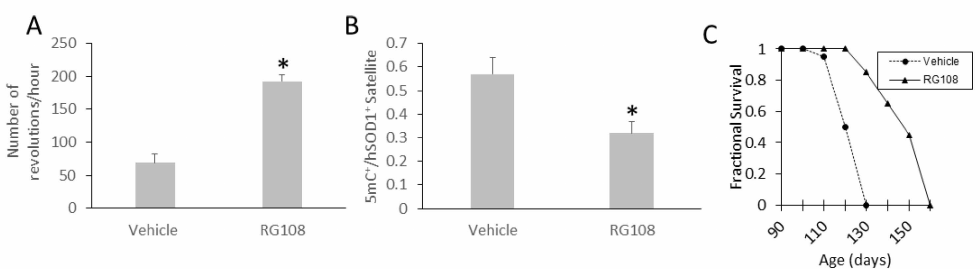
Figure 12. The DNMT inhibitor RG108 is therapeutic in nonconditional hSOD1-G93A mice. RG108 was given ip 2 mg/kg/day starting at 6 weeks of age. ( A ) RG108 restored significant (* p < 0.001) motor function (mean ± SEM) on a running wheel in 12-week-old mice ( n = 10/group). ( B ) RG108 significantly reduced (* p < 0.01) the accumulation of skeletal muscle satellite cells positive for 5mC (mean ± SD, n = 10/group). ( C ) RG108 treatment of hSOD1-G93A mice ( n = 20/group) delayed disease onset (vehicle 100 day versus RG108 120 days) and extended maximal survival from 130 days to 160